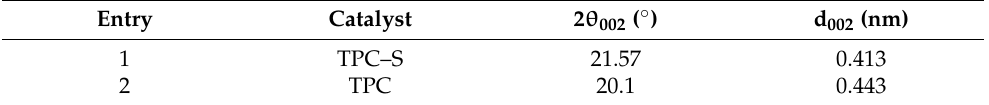
Table 1. The distance between carbon layers of TPC and